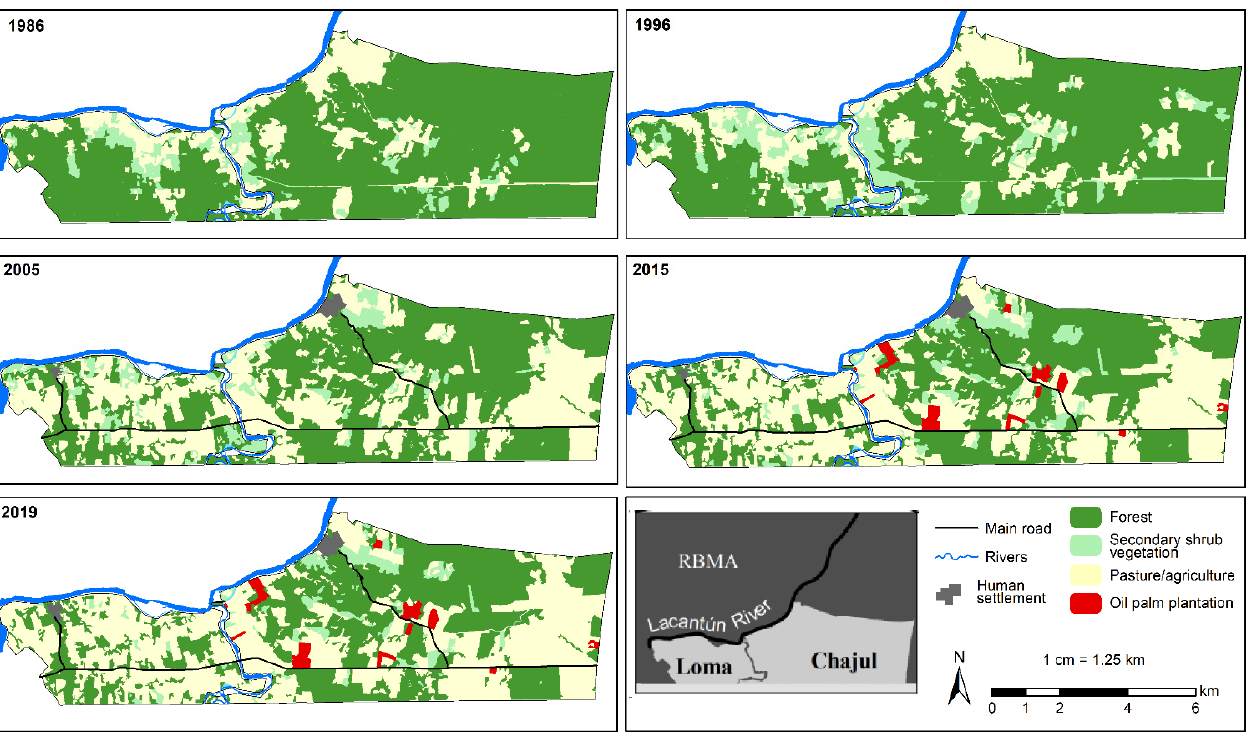
Figure 4. Land-use change maps of the study area from 1986 to 2019. Source: roads [25]; rivers [24]; ejido limits and human settlements [26].